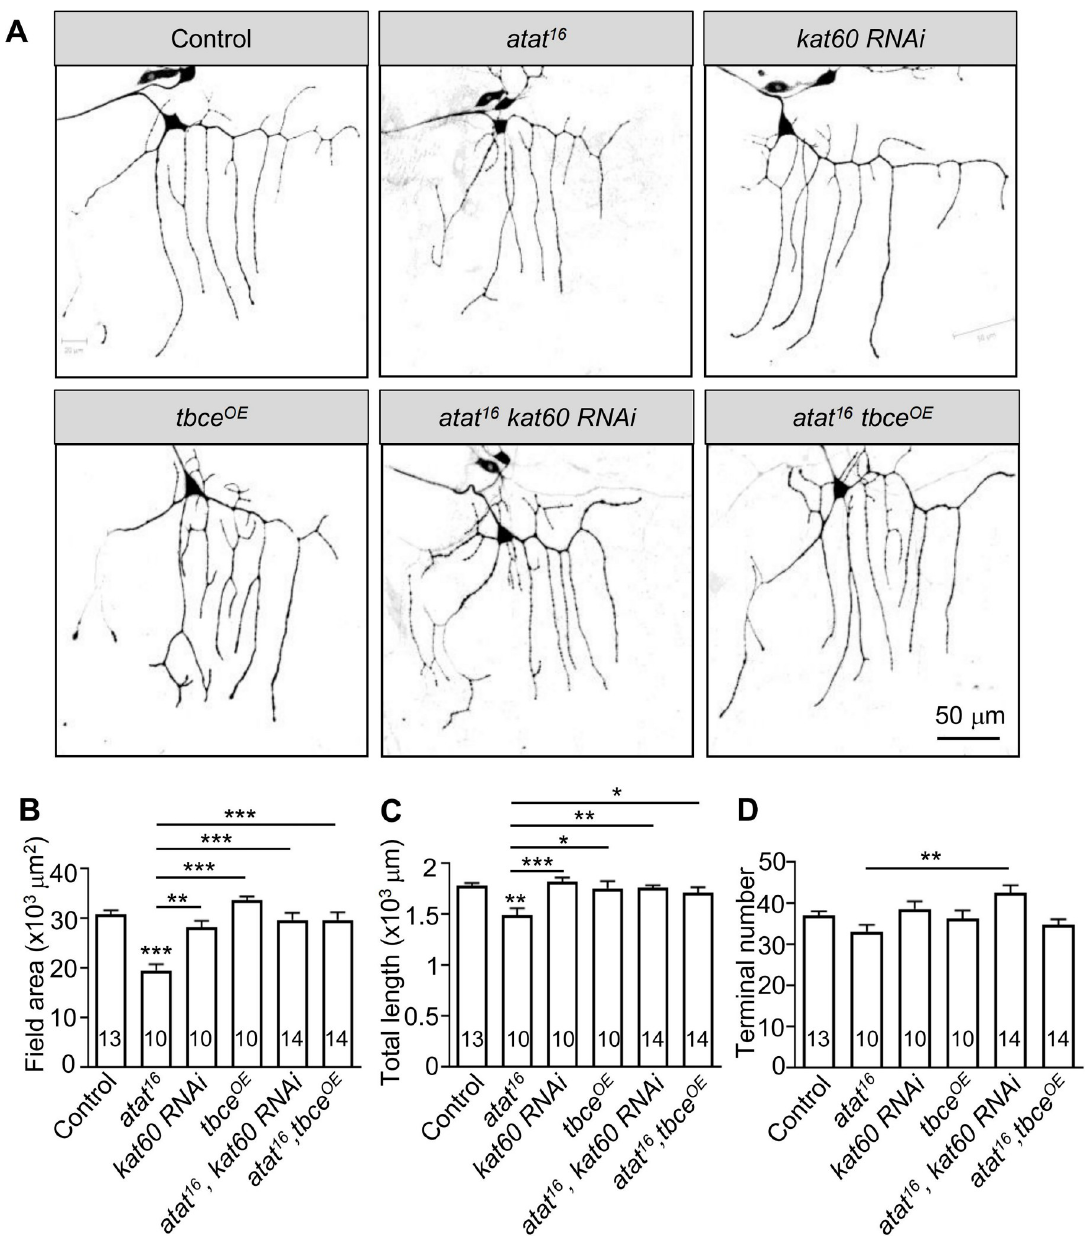
Fig 5. Increasing microtubule stability rescues the dendritic defects caused by atat mutation. (A) Dendritic elaboration of class I da neurons labeled with mCD8-GFP under the control of 221-Gal4 . The genotypes are the control ( 221-Gal4 > mCD8-GFP), atat 16 , katanin 60 knockdown using 221-Gal4 ( kat60 RNAi ), tbce overexpression using 221-Gal4 ( tbce OE ), katanin 60 knockdown in atat background ( atat 16 , kat60 RNAi ), and tbce overexpression in atat background ( atat 16 , tbce OE ). Scale bar: 50 μ m. (B–D) Quantification of total dendritic field areas (B), dendritic lengths (C), and the numbers of dendritic termini (D). Mean ± SEM. One-way ANOVA with Tukey’s multiple comparisons test. ��� p < 0.001, � p < 0.05.